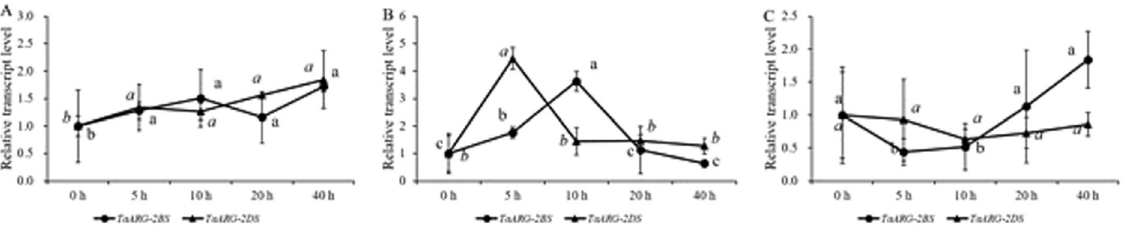
Figure 7. Transcript levels of TaARG genes in wheat leaves under abiotic stress. ( A ) Low temperature; ( B ) Drought; ( C ) NaCl. Each data point is an average of three biological repeats (mean ± SD). Small letters in bold or italic represent significant differences between TaARG-2BS and TaARG-2DS at α < 0.05 using Duncan’s multiple range test.